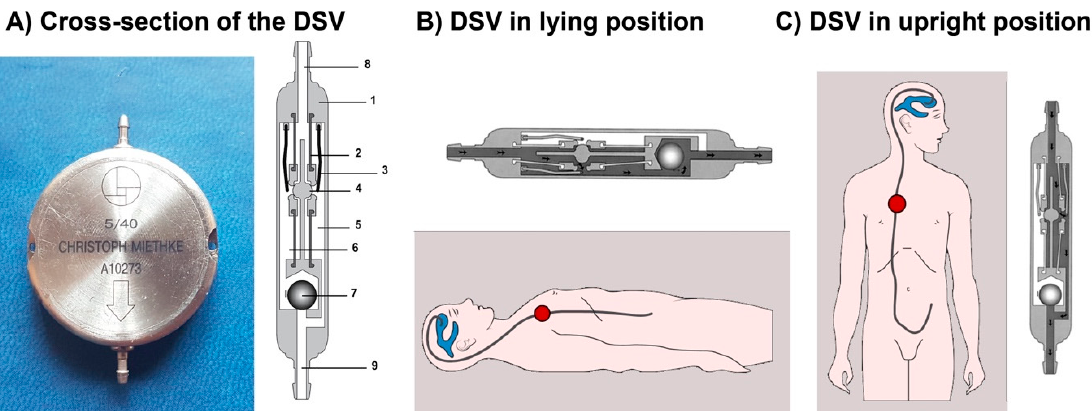
Figure 1. ( A ) Cross-section of the Miethke ® Dual-Switch valve (DSV). It has a solid titanium casing (1). Two titanium plates (3) are integrated into diaphragms made of silicone (2). Each plate, together with a ball (4), creates a valve seat, which is integrated into the casing as an opening and closing mechanism. Two different springs control the position of the plates. There is a stronger spring for the high-pressure chamber (5) and a weaker one for the low-pressure chamber (6). A heavy tantalum ball (7) is used to shift the flow path to either chamber. Titanium lips are used for the inlet (8) and outlet (9) tubing connection. When patients are supine ( B ), the low-pressure chamber operates like a conventional DPV and is activated when the differential pressure is above the opening pressure of the valve. In the upright position ( C ), the low-pressure valve is closed, and the postural changes move a tantalum ball that opens the flow path for the high-pressure controller [7].